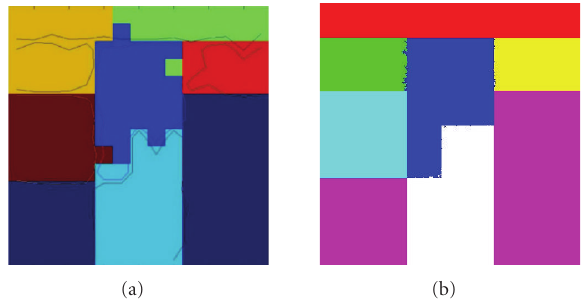
Figure 6: A slice of the synthetic tensor field used to test the seg- mentation method. (Image courtesy of Jonasson et al. [4].)